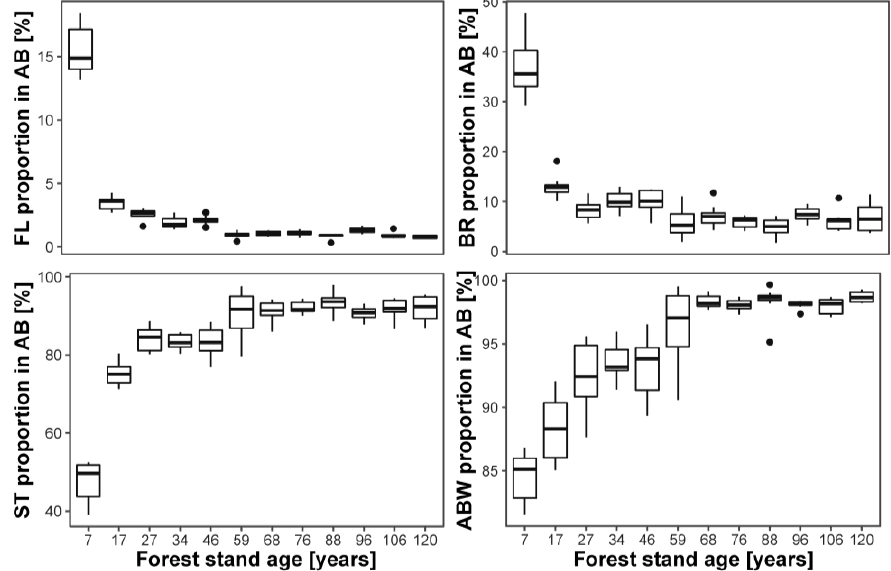
Figure 2. Proportion of foliage (FL), branches (BR), stem (ST) and woody aboveground (ABW)